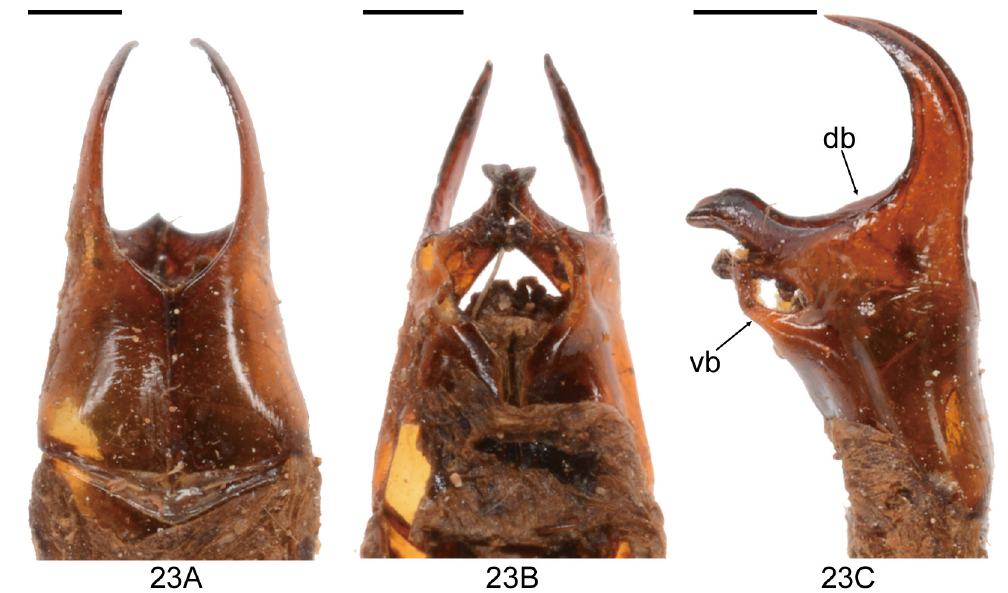
Fig. 23. Morphotype IX “ Ciliatipennis ”. Male genitalia of M. ciliatipennis (Moser, 1903), lectotype (MFNB). Parameres in dorsal (A), ventral (B) and lateral (C) views. Scale bars = 1.0